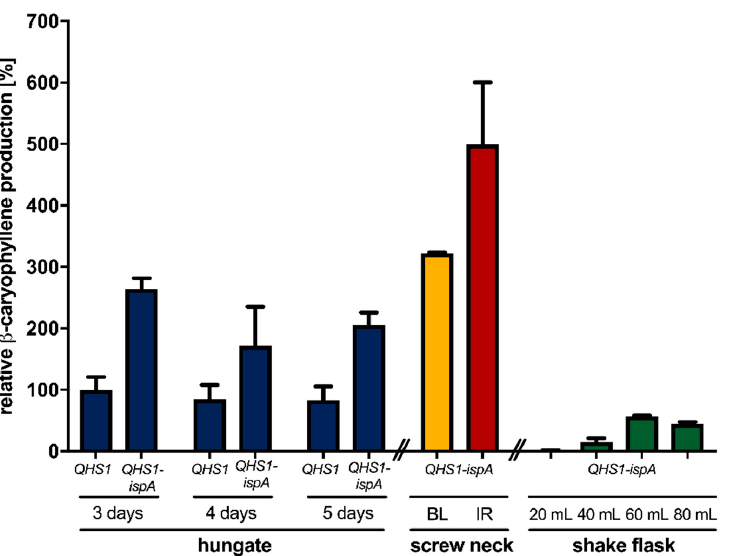
Figure 2. Heterologous β -caryophyllene production in the R. capsulatus strain SB1003-MVA with